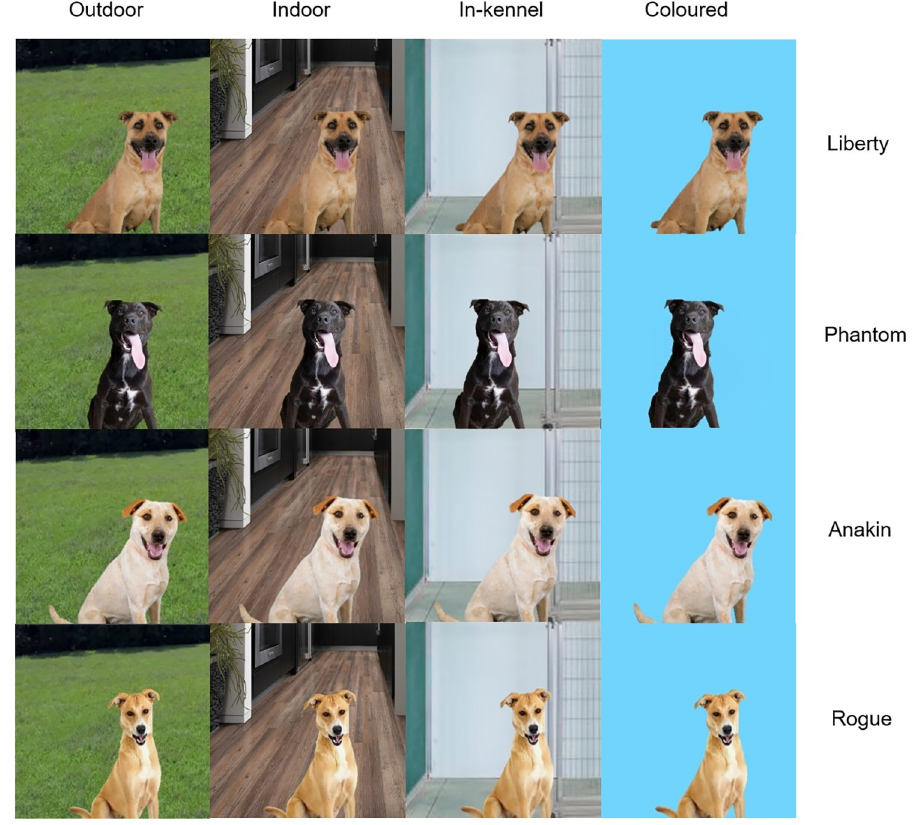
Fig 1. Dogs and backgrounds displayed online. From top to bottom, dogs present in this study were: Liberty, Phantom, Anakin, and Rogue. From left to right, background types present in this study were: outdoor, home indoor, in-kennel, and plain coloured backgrounds.